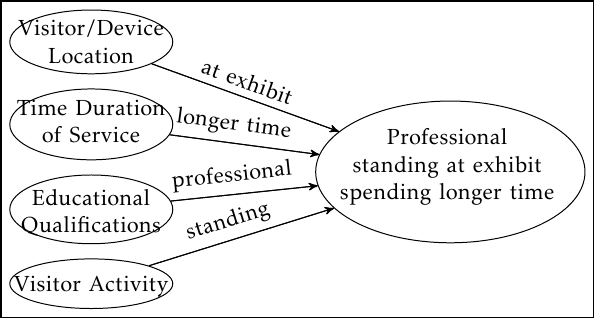
Figure 1. CC from Three’s Combination of Context Information